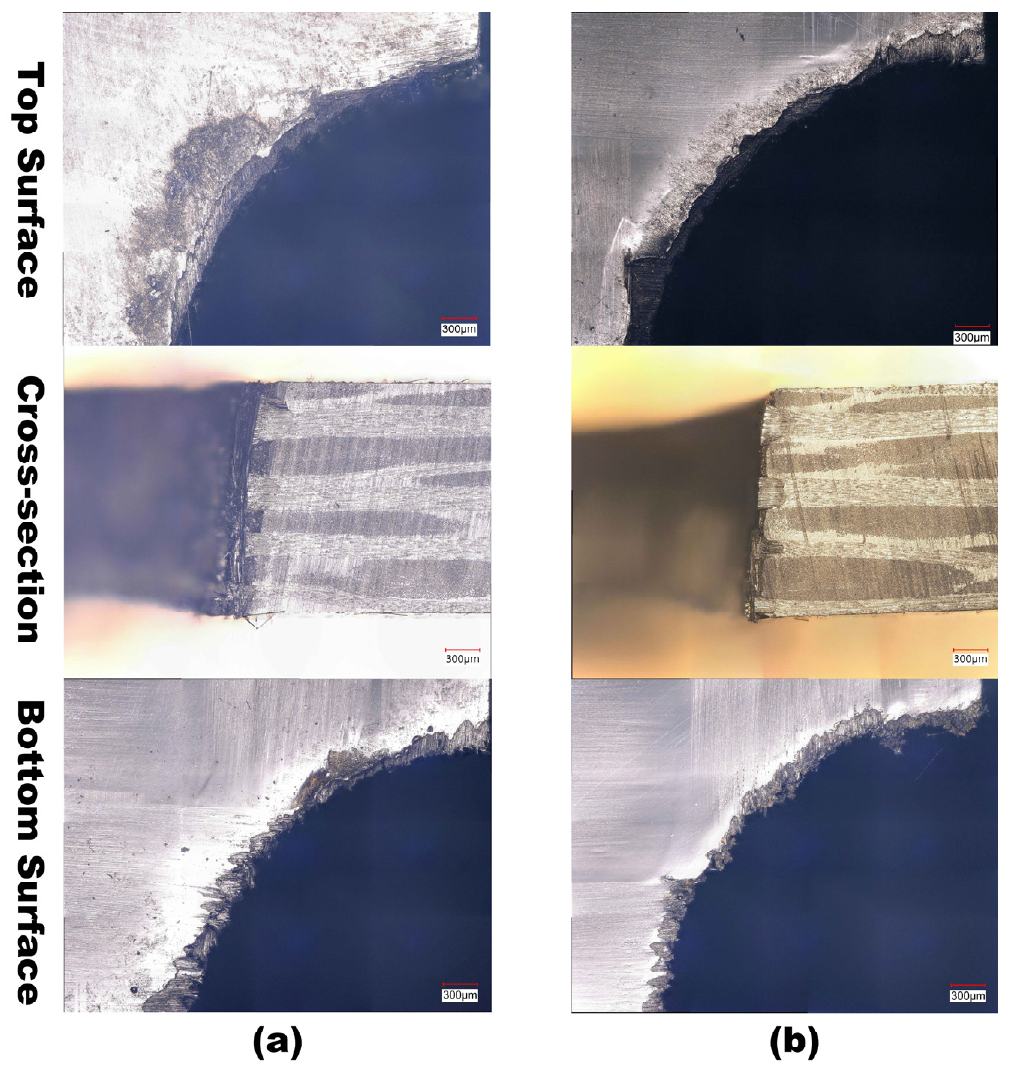
Figure 10. Optical images of CFRP workpieces drilled via the following different methods: ( a ) stepped laser parameter multiple-ring drilling method; ( b ) constant laser parameter multiple-ring drilling method.